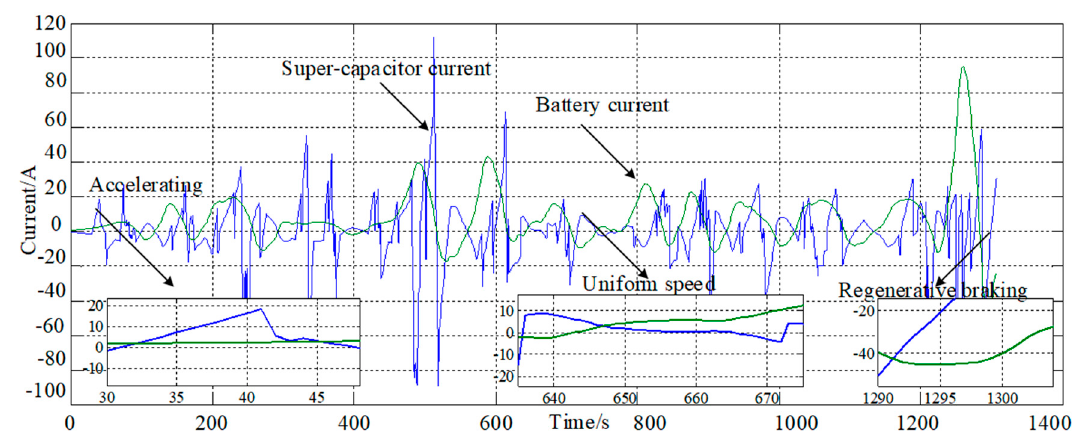
17 of 18 Figure 26. Motor controller bus current when braking. Battery current Super-capacitor current Figure 27. Battery and super-capacitor currents. Based on the above experimental analysis, in the proposed control method, the